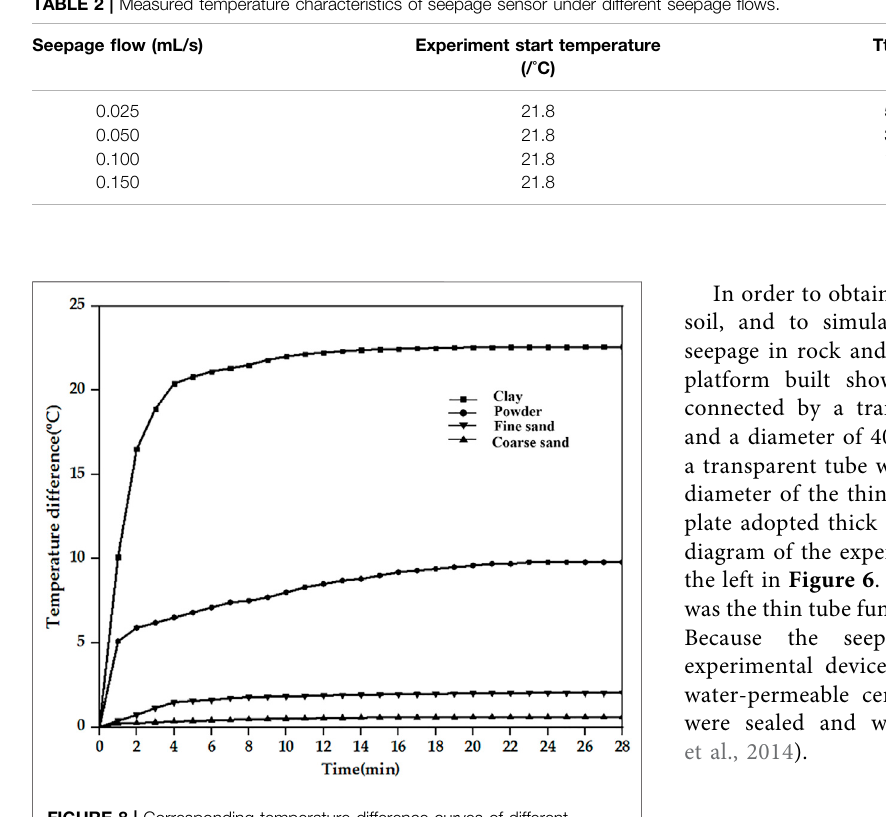
FIGURE 8 | Corresponding temperature difference curves of different diameter particles.